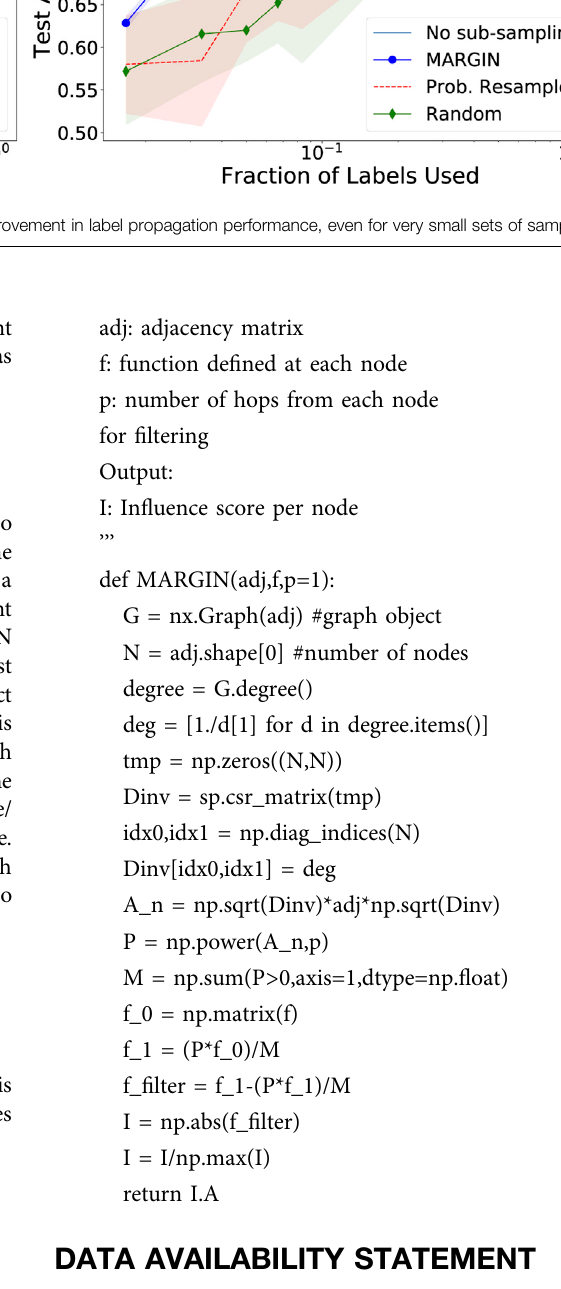
Frontiers in Big Data |